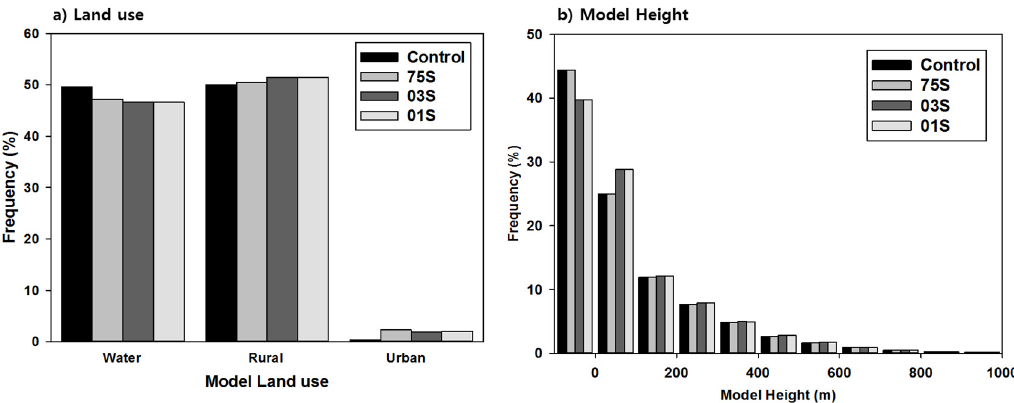
Figure 5. Histogram of frequency (%) versus ( a ) land use and ( b ) topographic altitude for the inner domain.